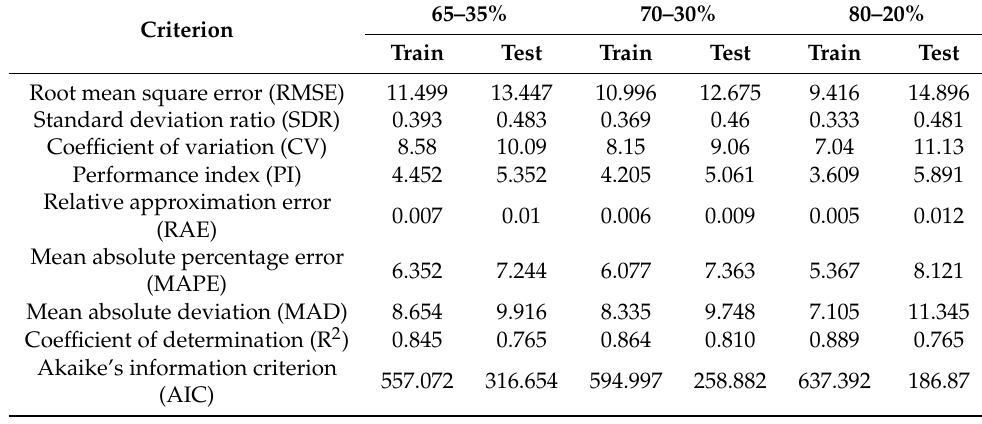
Table 3. Goodness-of-fit criteria results for each model.